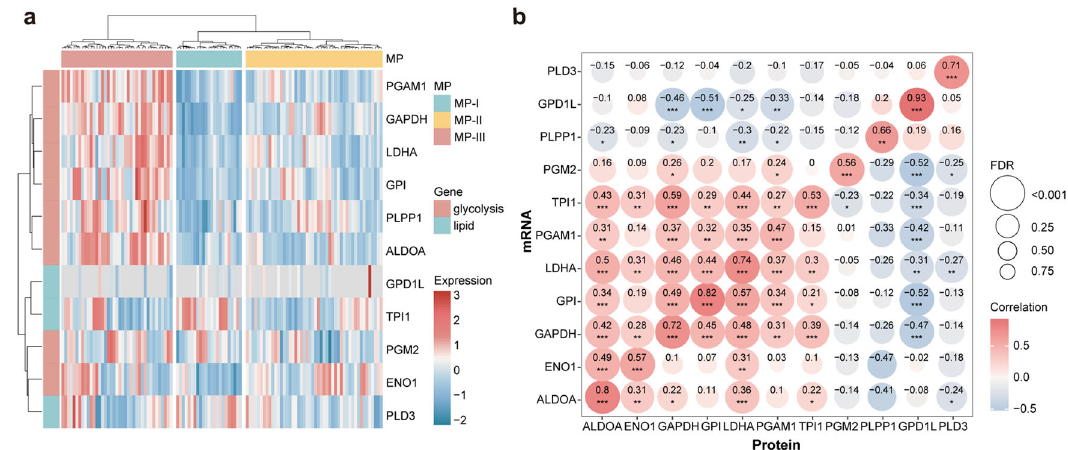
Fig. 4 Recon fi rming of metabolic phenotypes in the proteomic dataset. a Hierarchical clustering heatmap based on the protein expression ( Z -score) of the 11 metabolic genes from CPTAC. b Correlation matrix for the mRNA and protein expression of the 11